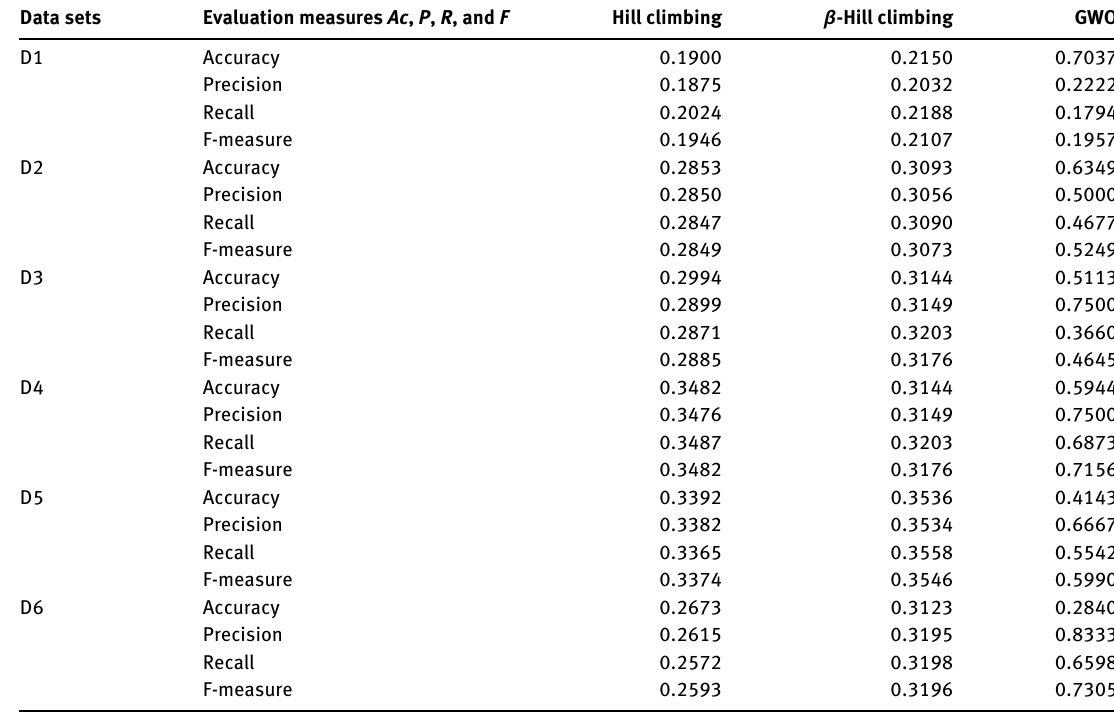
Table 4: A Comparison Performance Between TCP-based GWO, Hill Climbing, and β -hill Climbing in terms of the Reported Best Performance Text Clustering